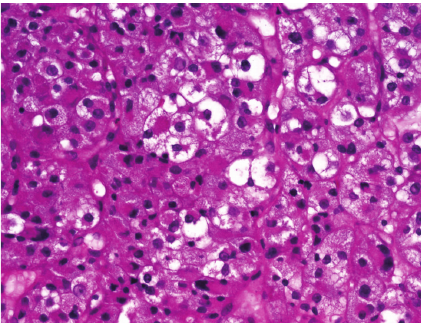
Figure 3: The cytoplasm of the tumor cells was broad and clear or eosinophilic. The nuclei were round and uniform, frequently with a single